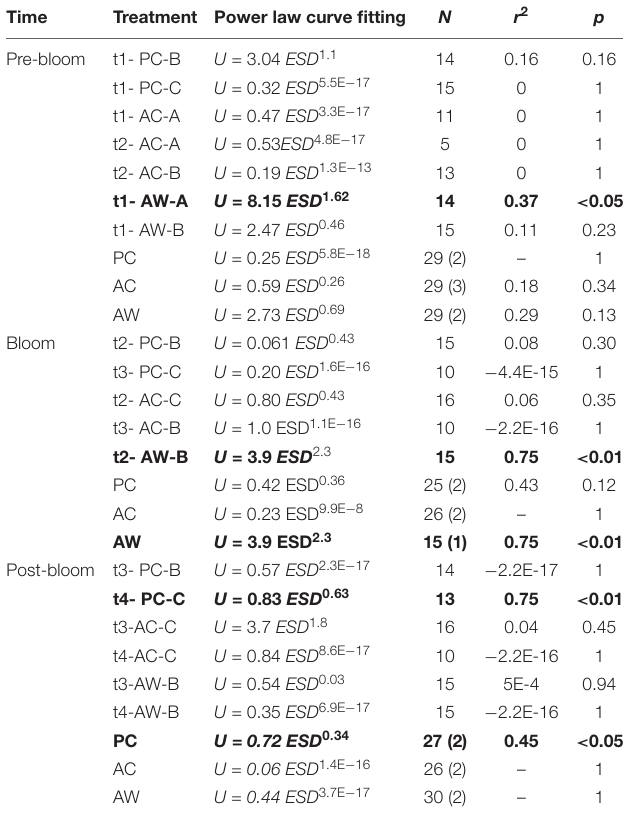
TABLE 2 | Relationship between sinking velocity ( U , cm s − 1 ) and size as equivalent spherical diameter ( ESD , cm) in each roller tank and bloom period. Time Treatment Power law curve